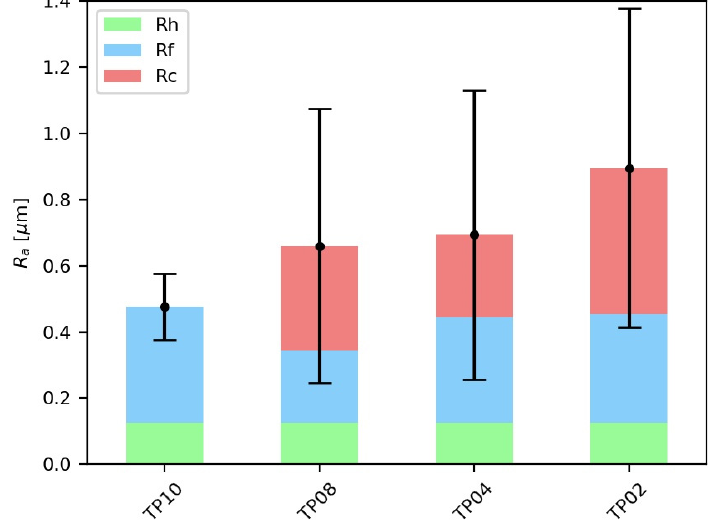
Figure 14. Components of the mean R a for each thin plate.